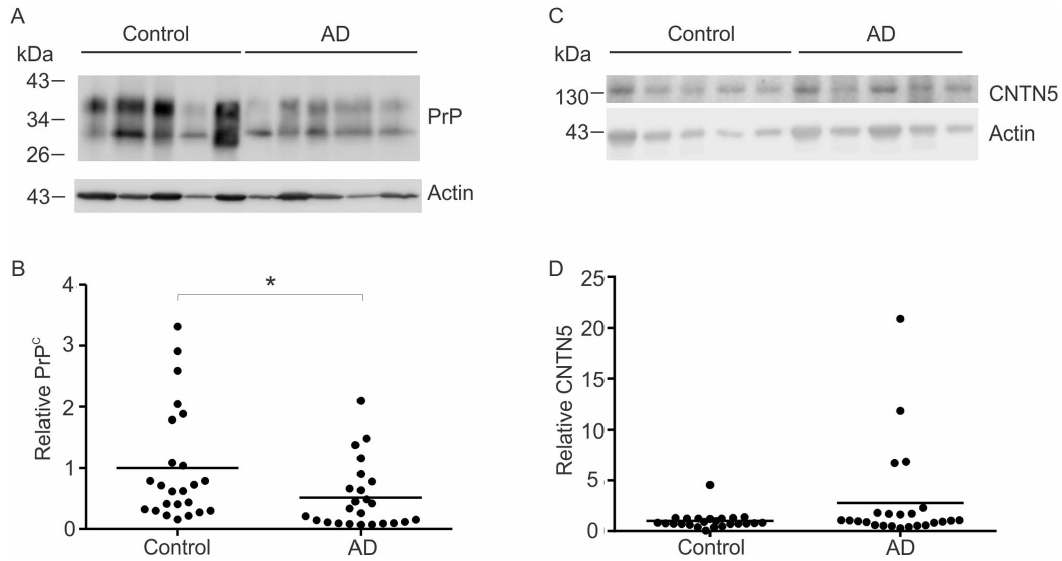
Figure 1. PrP C , but not CNTN5, is decreased in sporadic AD. Representative immunoblots of PrP C and actin in temporal cortex samples from sporadic AD patients compared to age-matched controls (A) with densitometric analysis relative to actin levels represented in a grouped scatter plot (B). Representative immunoblots of CNTN5 relative to actin (C) with densitometry analysis (D). Line represents mean, *p , 0.05, n=24 per group.